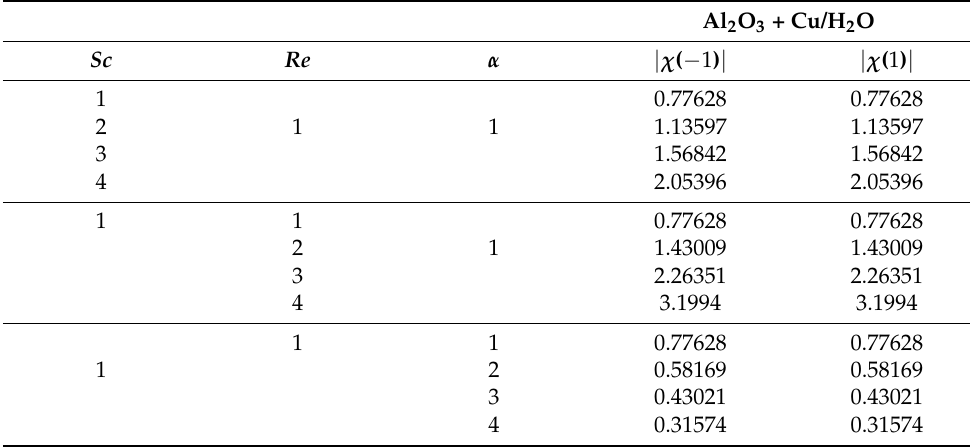
Table 6. Simulation results of the numerical impact of flow mass transfer at the lower and upper disks for Al 2 O 3 + Cu/H 2 O HN fd